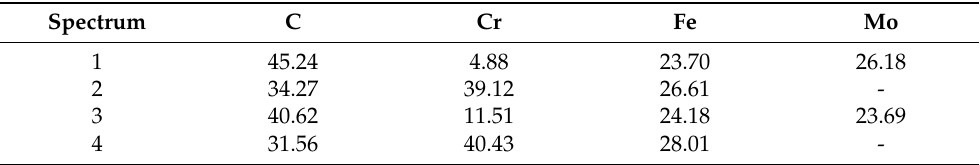
( b ) Figure 13. Presence of carbides M 2 C, associated with Mo. The numbers 1 ‐ 4 correspond to the spectra in Table 8: ( a ) exper ‐ iment 2; ( b ) experiment 7. Images obtained in a back scattered electron detector. Table 8. Semi ‐ quantitative analysis of phases shown in Figure 13a,b. This analysis was carried out through an energy dispersive X ‐ ray microanalysis (EDX). (% atomic). Spectrum